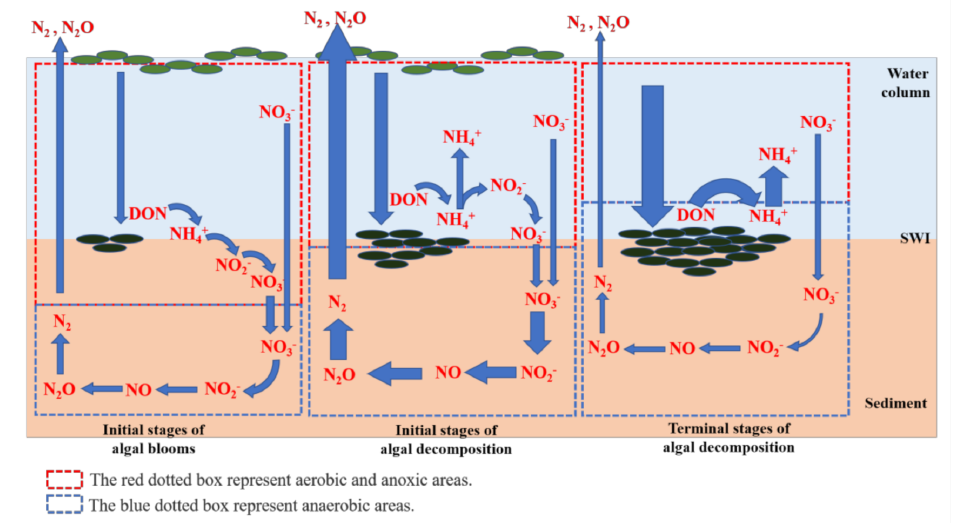
Figure 8. Conceptual diagram of the effect of different cyanobacteria biomass decomposition on sedi- ment nitrogen cycling at the sediment–water interface (SWI) in eutrophic freshwater lake